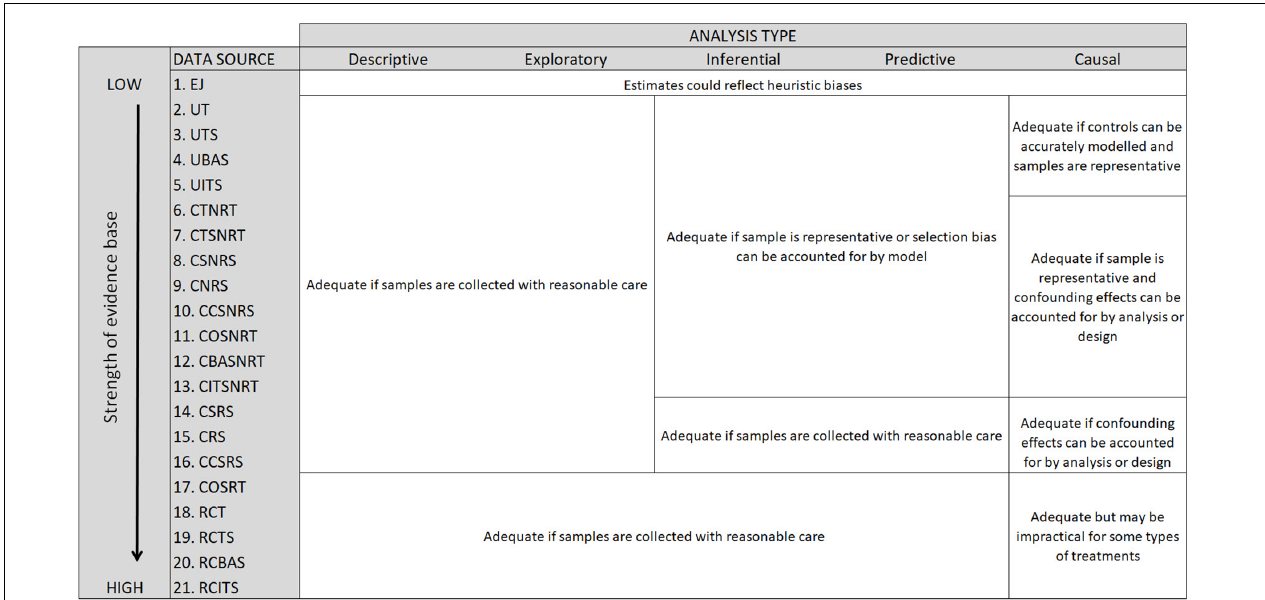
FIGURE 5 | Summary of the adequacy of the evidence base, and associated key issues, when considering the types of questions that marine reserve managers might try to answer with data obtained from different levels of the evidence hierarchy. Study design codes are as follows: (1) Expert judgment (EJ), (2) Uncontrolled trial (UT), (3) Uncontrolled time series (UTS), (4) Uncontrolled before after study (UBAS), (5) Uncontrolled interrupted time series (UITS), (6) Controlled trial with non-randomized treatment (CTNRT), (7) Controlled time series with non-randomised treatment (CTNRT), (8) Cross sectional analysis with non-representative sample (CSNRS), (9) Cohort study with non-randomised sample (CNRS), (10) Case control study with non-representative sample (CCSNRS), (11) Cross over study with non-randomised treatment (COSNRT), (12) Controlled before after study with non-randomised treatment (CBASNRT), (13) Controlled interrupted time series with non-randomised treatment (CITSNRT), (14) Cross sectional analysis with representative sample (CSRS), (15) Cohort study with representative sample (CRS), (16) Case control study with representative sample (CCSRS), (17) Cross over study with randomised treatment (COSRT), (18) Randomised controlled trial (RCT), (19) Randomised controlled time series (RCTS), (20) Randomised controlled before-after study (RCBAS), and (21) Randomised controlled interrupted time series